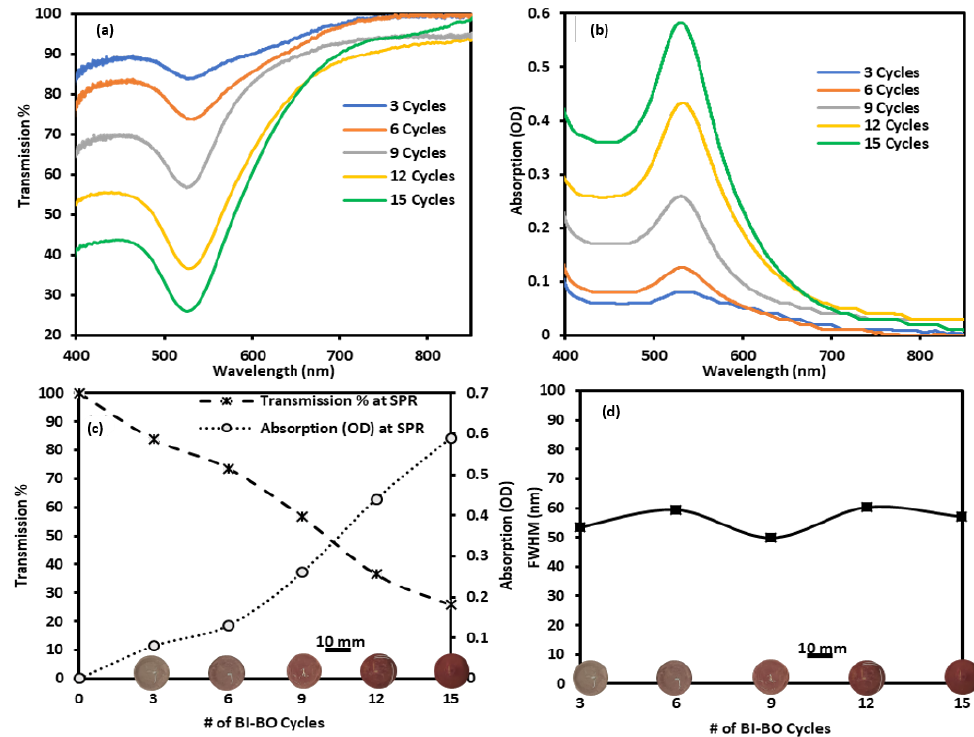
Figure 4. Utilization of BI-BO method to incorporate GNPs-MPA into hydrogels and their corre- sponding optical properties. ( a ) Transmission and ( b ) absorption spectra of the gels. Variation of the ( c ) transmission percentage, absorption at the surface plasmon, and ( d ) FWHM of the GNPs-MPA gels as a function of the number of BI-BO cycles. Images of the gel at each cycle are shown in the x- axis.